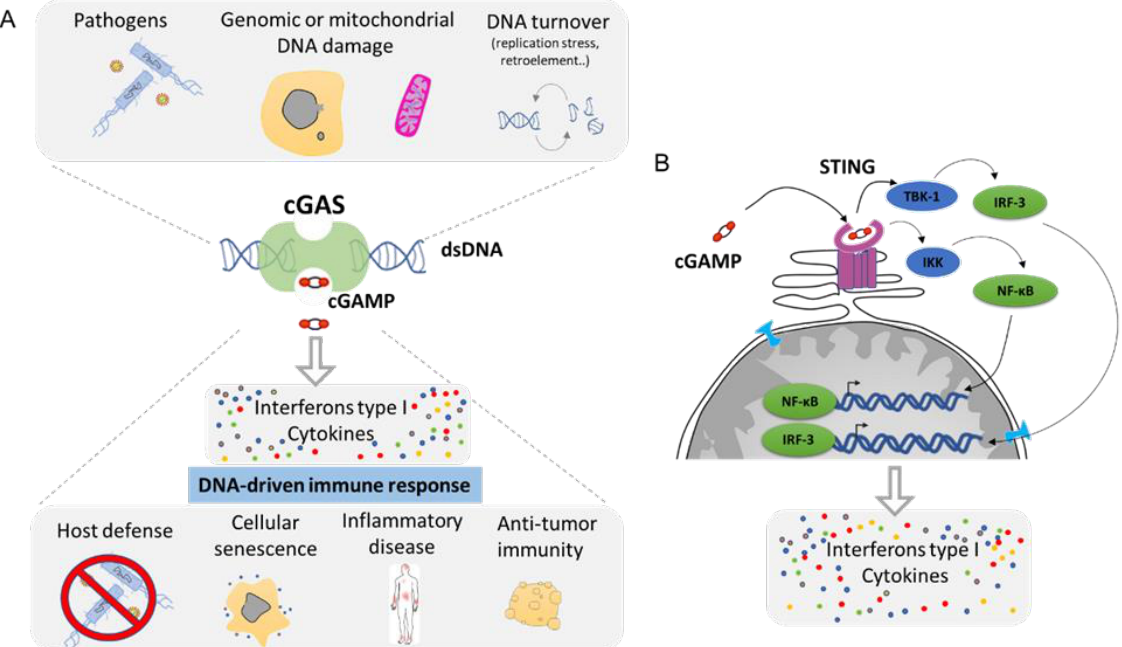
Figure 6. The cGAS–cGAMP–STING signaling pathway: a universal sensor for double-strand DNA (dsDNA). ( A ). cGAS function is to sense DNA from the cytoplasm as result of infection, genomic, or mitochondrial instability. cGAS activation through the generation of cGAMP will drive the activation of the innate immune response and leads to the secretion of Interferon type 1 as well as a cocktail of cytokines. ( B ). Molecular mechanism of cGAS/STING pathway. cGAMP is the ligand for the STING receptor (shown in pink) and results in the activation of the transcription regulator factors NF-κβ and IRF-3 that drive the secretion of several pro-inflammatory molecules (Adapted from Ablasser et al. [100] and Motwani et al. [97]).